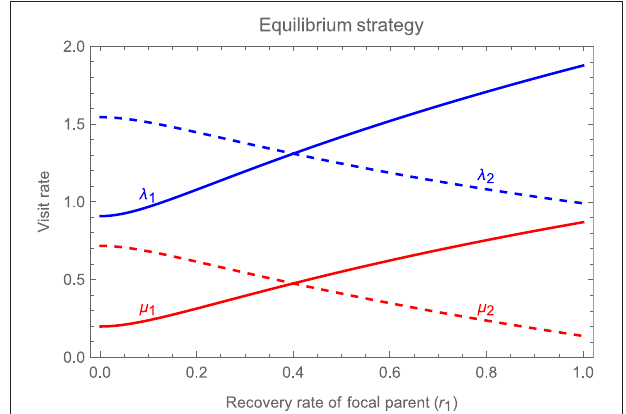
l FIGURE 6 | Changes in the stable alternating strategy, as one varies a focal parent’s recovery rate independently of its partner’s recovery rate (i.e., allowing for asymmetries between the parents). Solid curves show the visit rates of the focal parent, λ 1 (immediately after it detects a visit by its partner) in blue and µ 1 (immediately after visiting the young itself) in red, while dashed curves show the corresponding visit rates of the partner, λ 2 in blue and µ 2 in red, all as a function of the focal parent’s recovery rate r 1 (while holding the partner’s recovery rate r 2 constant at a value of 0.4). As in Figures 4 , 5 , the fitness payoff to a parent is equal to bB − cC f or bB − cC m , where B denotes the mean rate at which offspring receive feeds while hungry and C f or C m the mean rate at which the female or male parent visits the young while in a refractory state, with b = 1 and c = 0.2. Other parameter values are d f = d m = 0.9 and h =